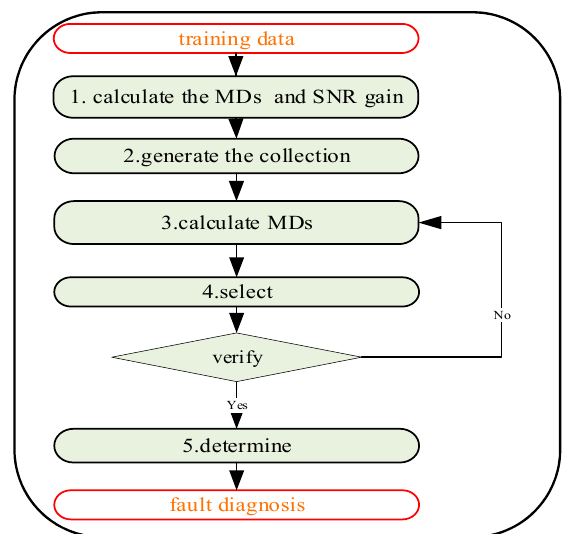
Figure 2. The step of Multiclass–Mahalanobis–Taguchi system (aMMTS). Sensors 2018 , 18 , x FOR PEER REVIEW